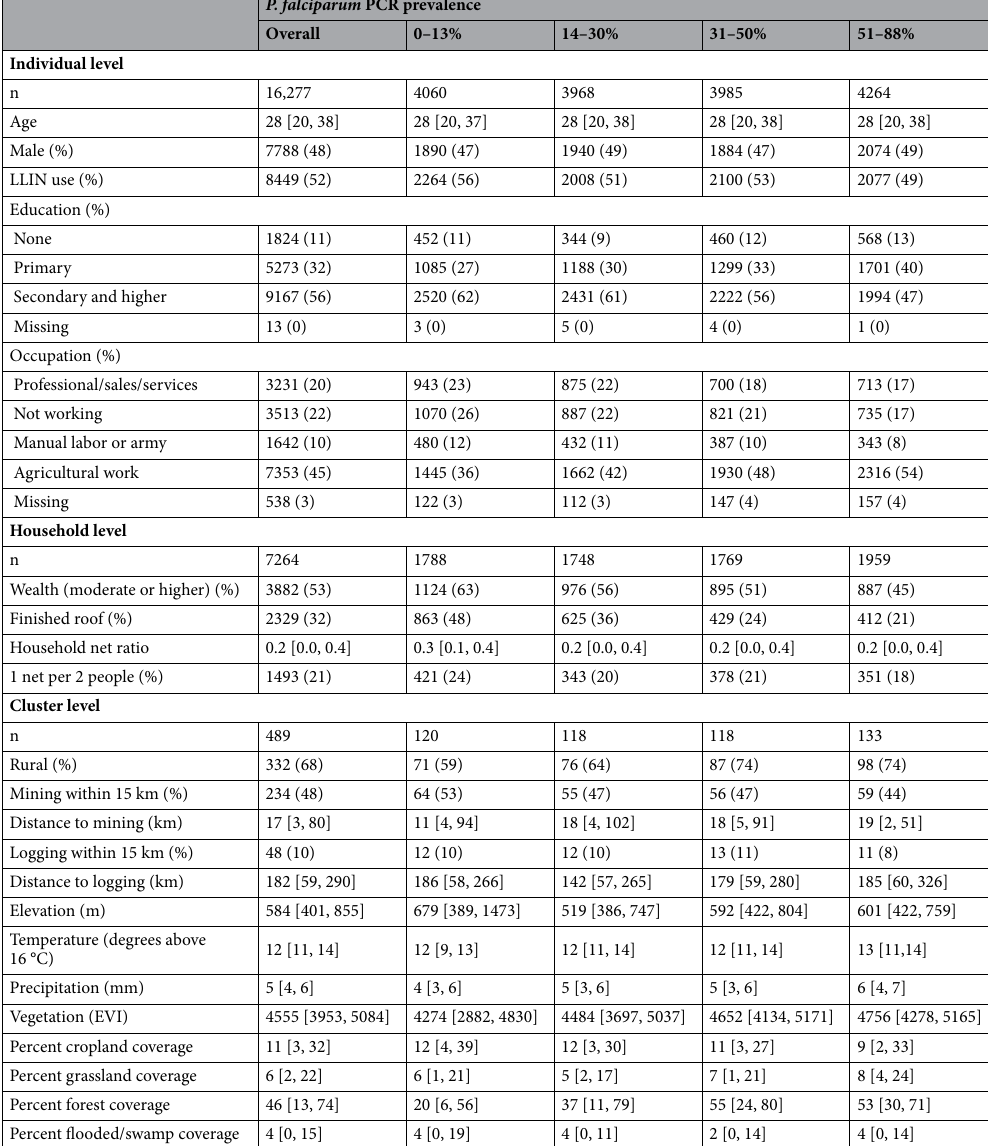
Table 1. Characteristics of the study population stratified by quartile of P. falciparum cluster prevalence and grouped by level of observation (individual, household, and cluster). Data are n (%) or median